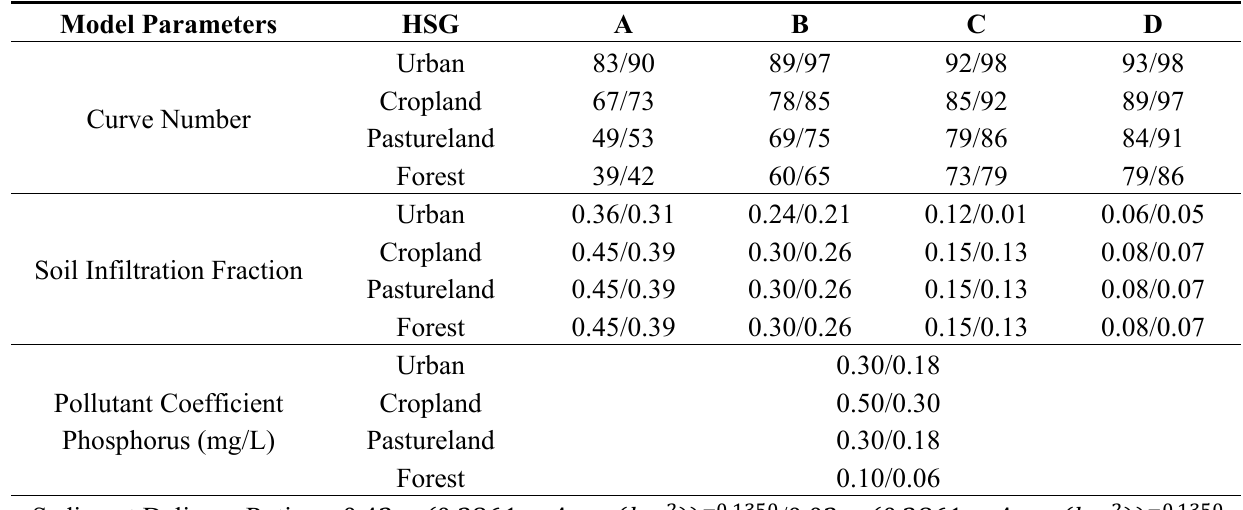
Table 5. STEPL WEB parameters (default/calibrated).